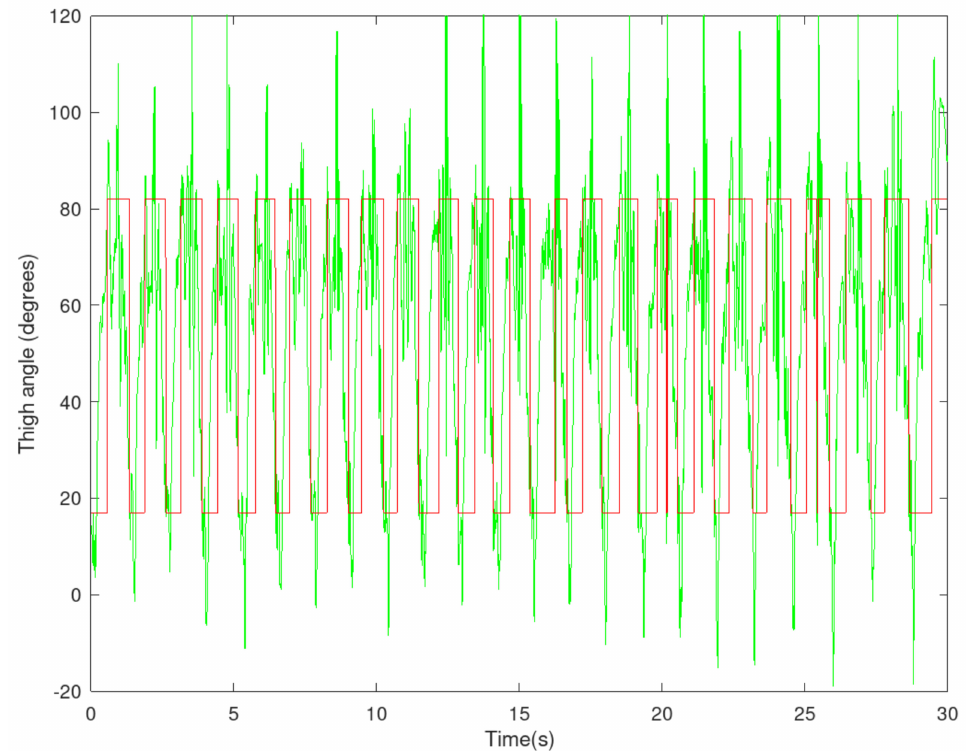
Figure 7. Graphical representation of the outcomes of a 30-s CST in the presence of some transitions with harmful levels of noise. The green line represents the estimation of the thigh angle over time, while the red line represents the transitions detected by the hysteresis algorithm. The transitions around Time = 20 and Time = 25 show a strong and narrow inverse peak of noise that tricks the algorithm into detecting a spurious StSi transition, and then another spurious SiSt transition. Thus, an extra SiSt transition was detected for each of them, and the final score was overestimated by two points; 25 SiSt transitions were reported instead of